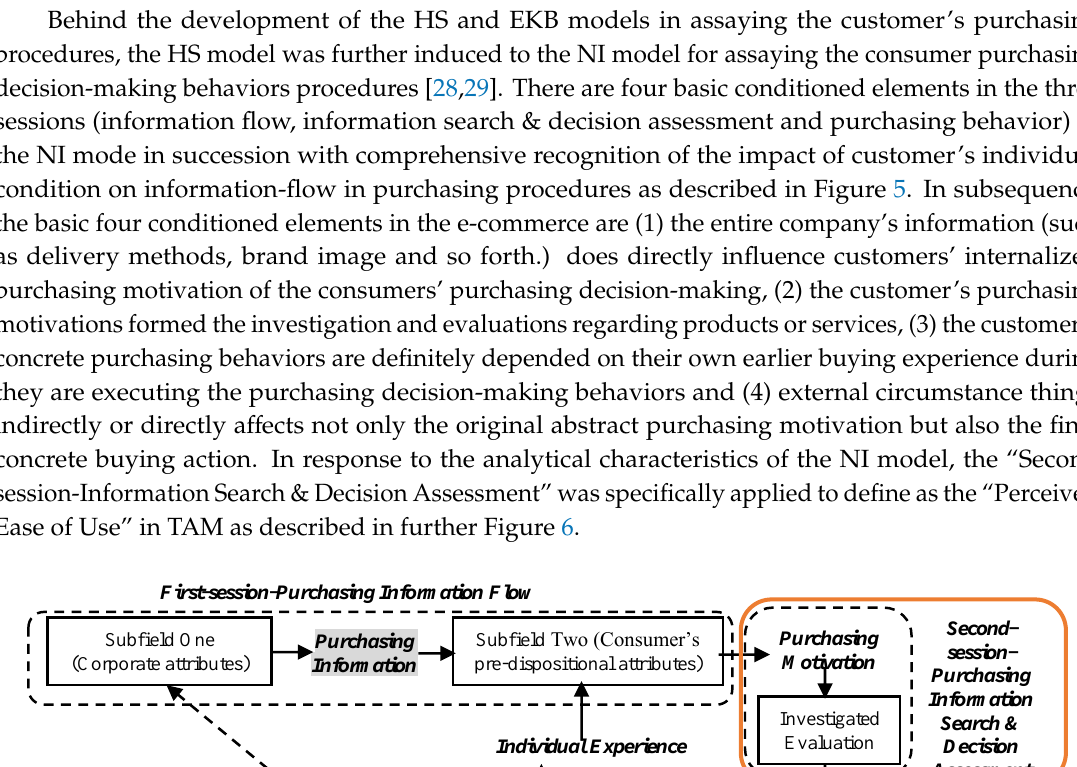
Figure 4. The Main Purchasing Procedures of EZB mode.